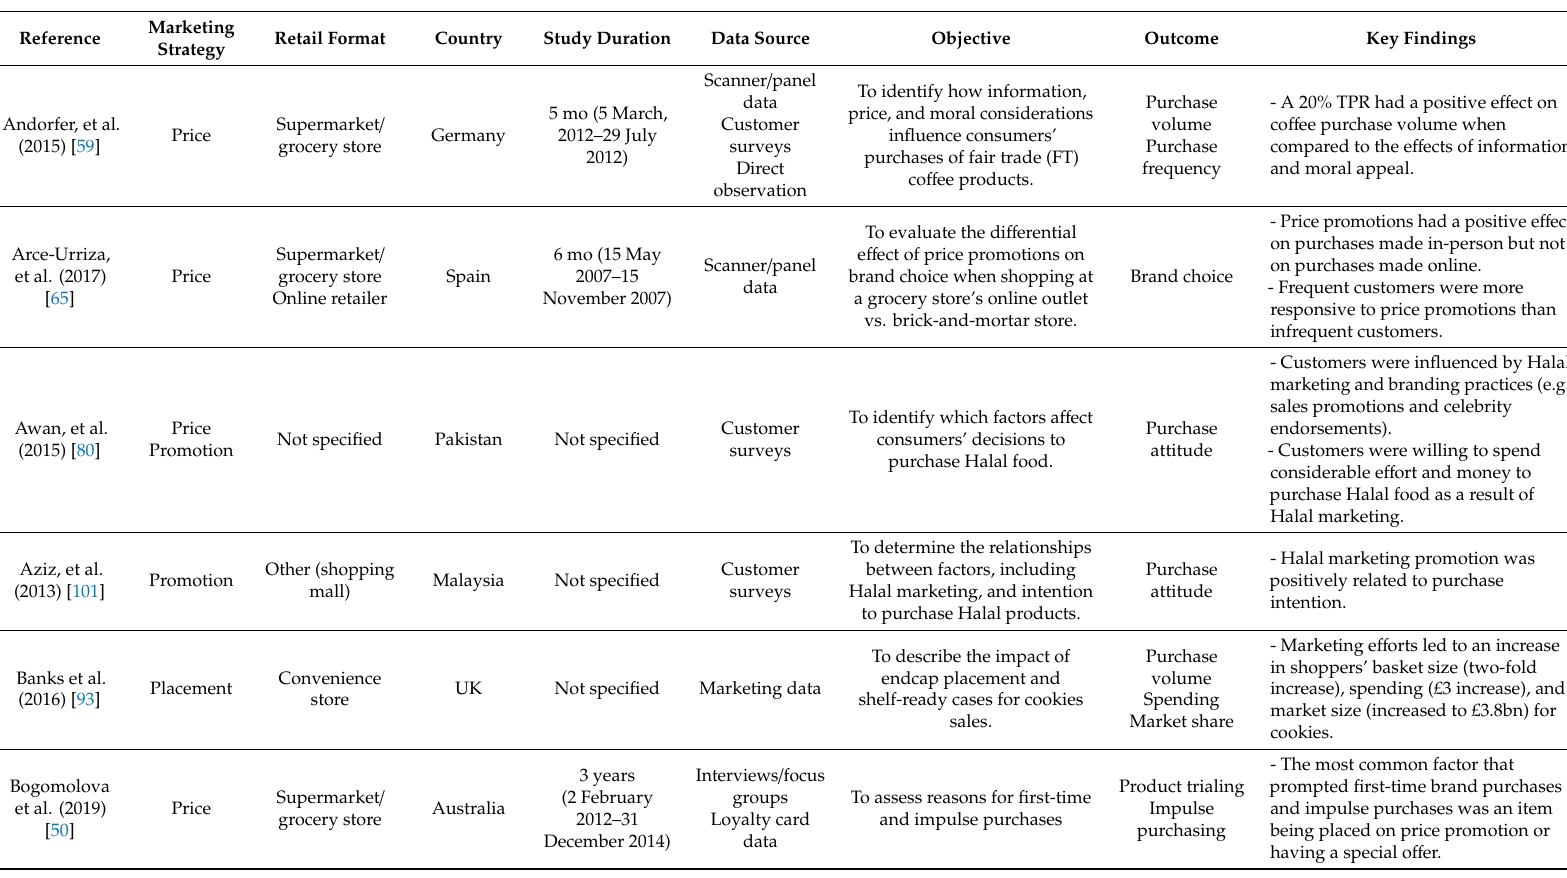
Table 2. Study design, marketing strategy, retailer format, country, study duration, data source, objectives, outcomes, and key findings for studies included in research Question 2 ( n =